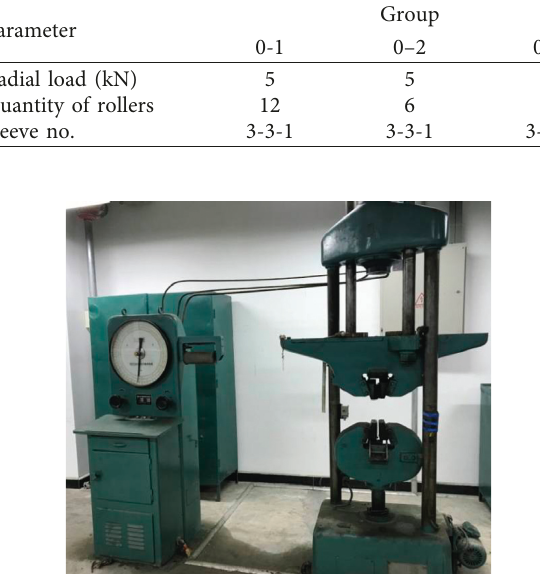
Figure 5: Universal material